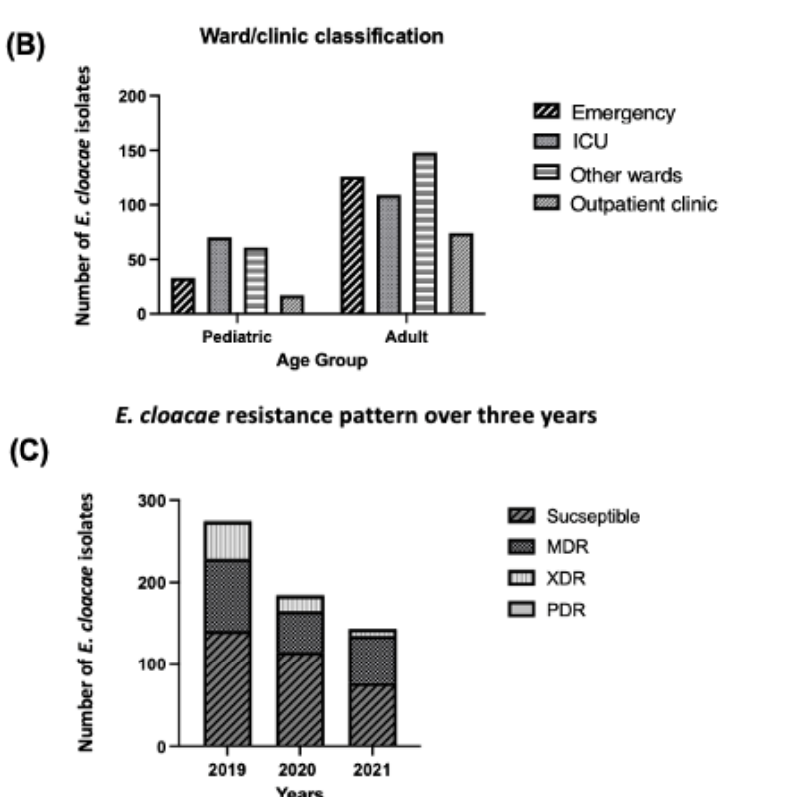
Figure 1. Demographic, clinical and baseline laboratory sample size distribution over a three-year period between (2019–2021). ( A ) Age description for male and female. ( B ) Ward/clinic description for pediatric and adult. ( C ) E. cloacae resistance pattern. MDR, XDR, PDR.